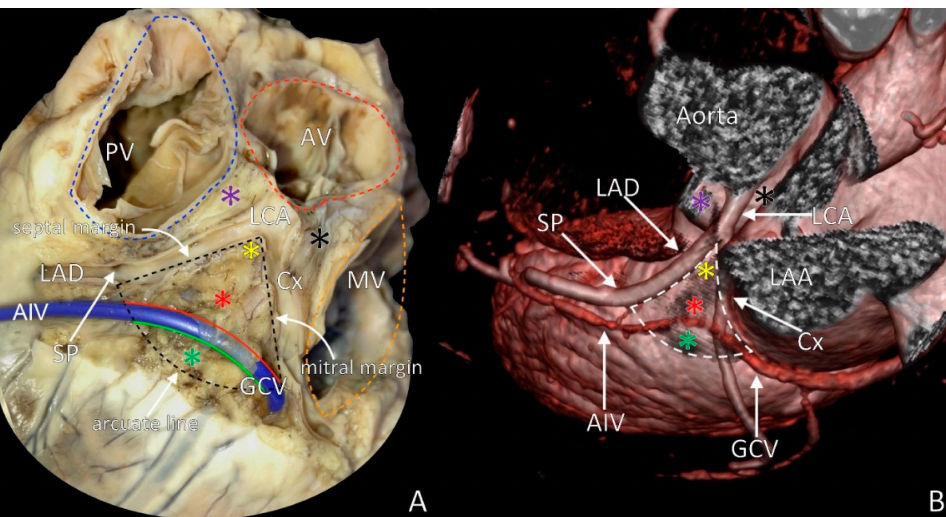
Figure 1. The left ventricular summit (LVS) with marked boundaries. ( A ) The LVS in heart cadaveric specimen; ( B ) LVS in medical imaging visualization (angio-computed tomography rendered image). Red asterisk = inaccessible area, green asterisk = accessible area, violet asterisk = septal summit, black asterisk = aortic–mitral continuity, yellow asterisk = apex of LVS, AIV = anterior interventricular vein, AV = aortic valve, Cx = circumflex branch of left coronary artery, GCV = great cardiac vein, LAA = left atrial appendage, LAD = left anterior descending artery, LCA = left coronary artery, MV = mitral valve, PT = pulmonary trunk, PV = pulmonary valve, SP = septal